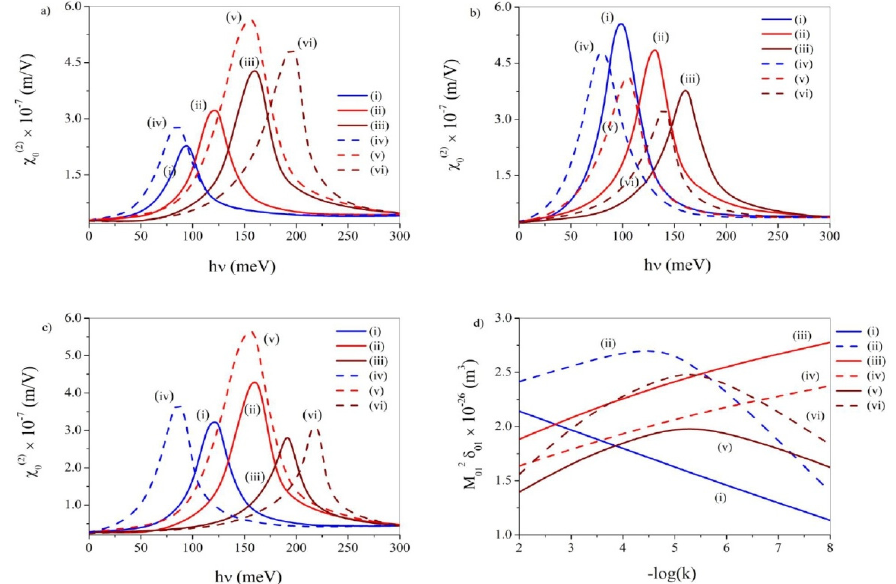
Figure 5. NOR vs. h υ diagrams ( a ) devoid of noise, ( b ) under ADWN and ( c ) under MLWN. In these diagrams the anharmonicity has (i) odd parity and k = 10 − 8 , (ii) odd parity and k = 10 − 5 , (iii) odd parity and k = 10 − 2 , (iv) even parity and k = 10 − 8 , (v) even parity and k = 10 − 5 , (vi) even parity and k = 10 − 2 . ( d ) Depiction of GF for NOR vs. − log(k): (i) devoid of noise and OPA, (ii) devoid of noise and EPA, (iii) with ADWN and OPA, (iv) with ADWN and EPA, (v) with MLWN and OPA and (vi) with MLWN and EPA.